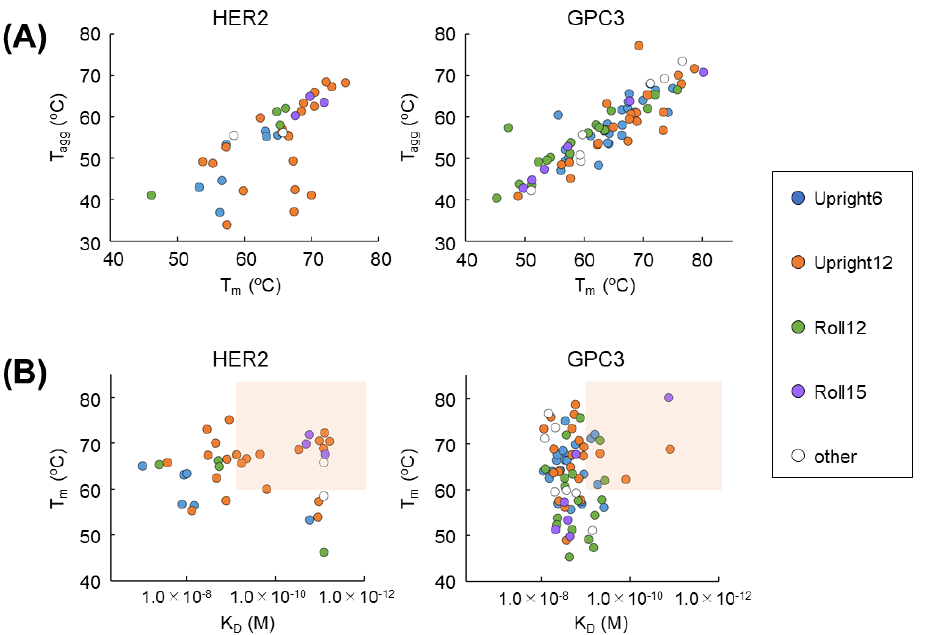
Figure 5. Characteristic of obtained VHHs. ( A ) T m –T agg and ( B ) K D –T m diagram of unique VHH clones against HER2 and GPC3, shown for the sub-library origin of each VHH clone: Upright 6 (blue), Upright 12 (orange), Roll 12 (green), Roll 15 (purple), and other (white). The region of high affinity (<1.0 × 10 − 9 M) and high thermal stability (>60 °C) is highlighted in red.